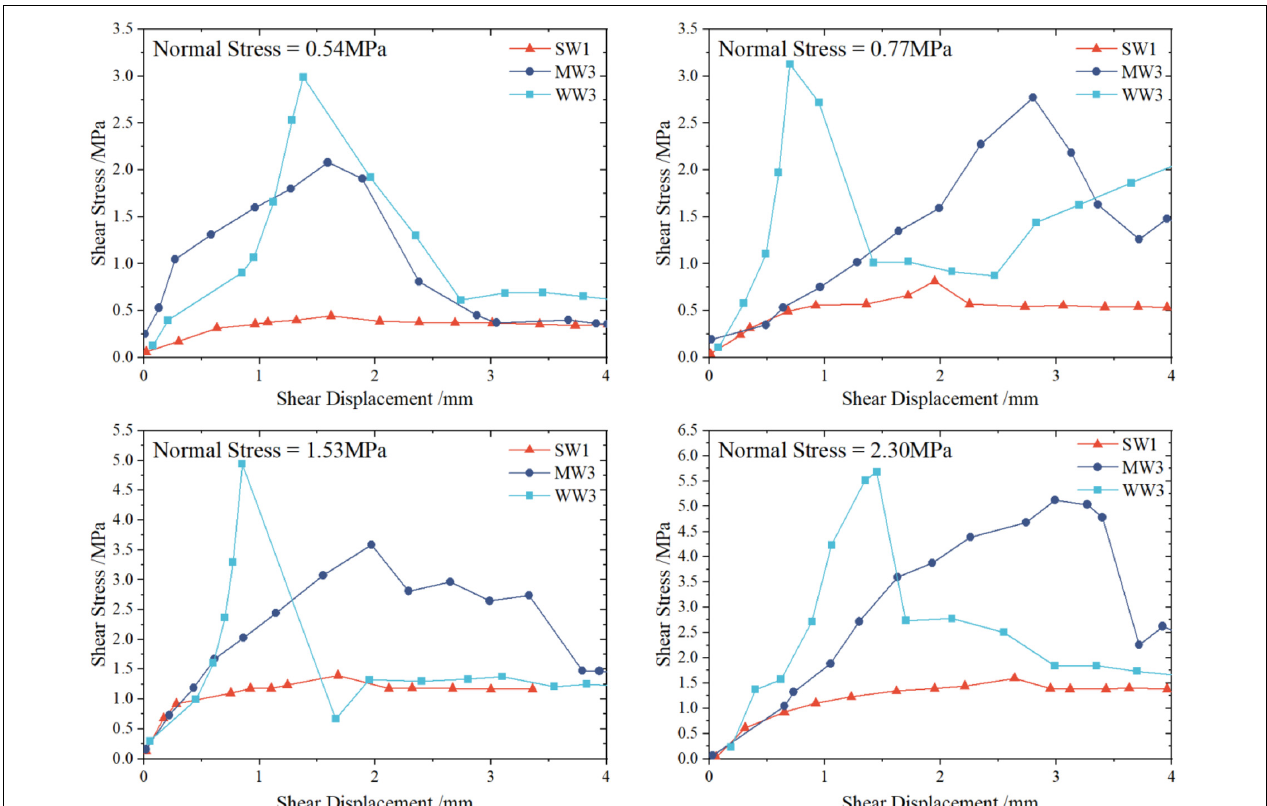
FIGURE 5 | Shear stress–displacement curves of weathered diorite-porphyrite specimens under direct shear tests.